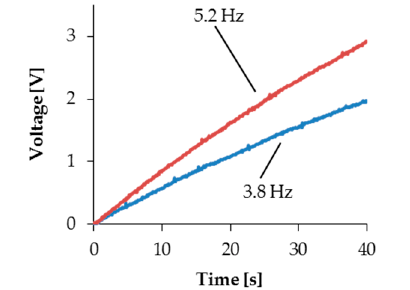
Figure 9. Charging of a capacitor with 200 μ F with PZT stripes on vibrating